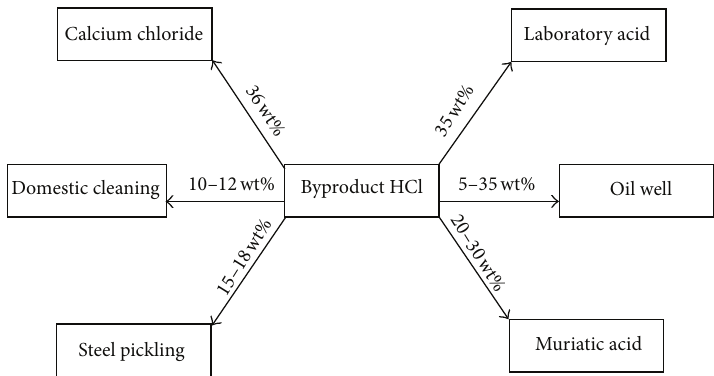
Scheme 1: Uses of HCl recovered as byproduct